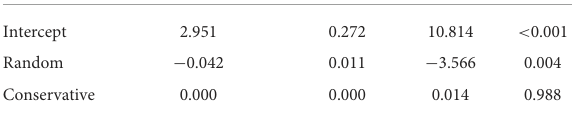
TABLE 4 Results from the gls model test if the functional groups occur at distinct aridity